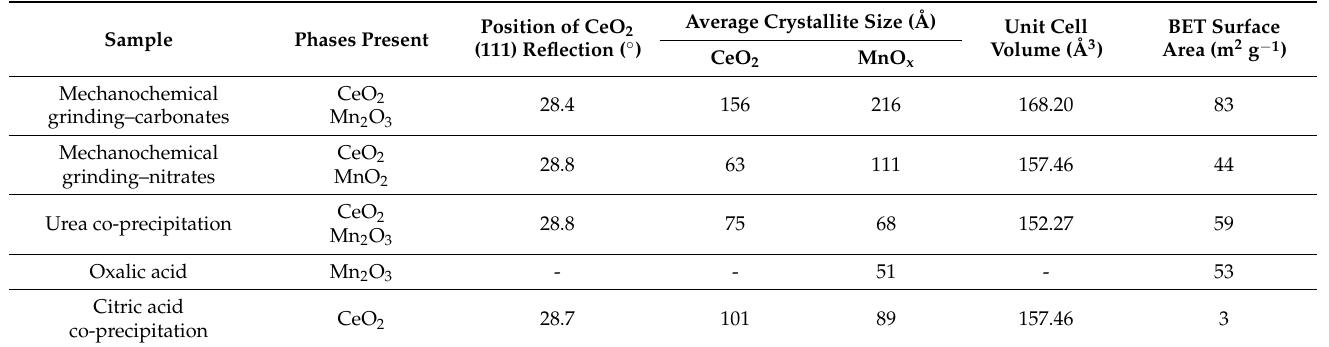
Figure 9. Powder XRD scattering patterns of Ce 0.25 Mn 0.75 O x catalysts. ▪— ceria phases, * — MnO 2 phases, + — Mn 2 O 3 phases. Table 3. Physical properties of Ce 0.25 Mn 0.75 O x catalysts.